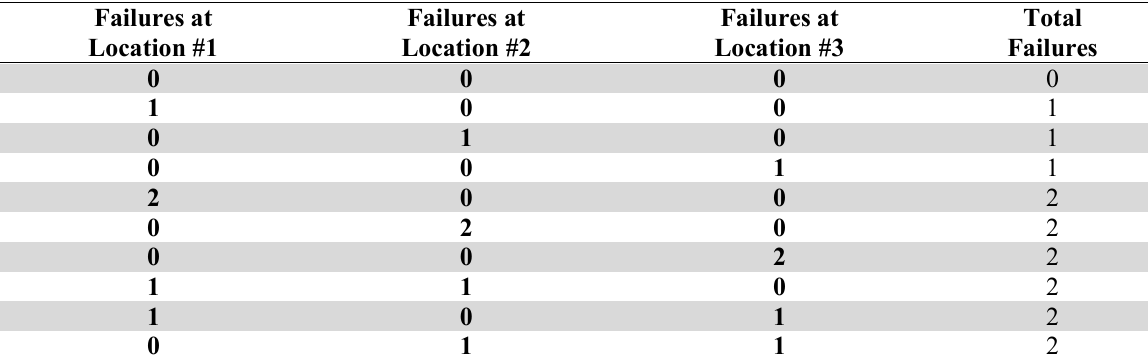
The combinatorial table for M i = 3 and N i =